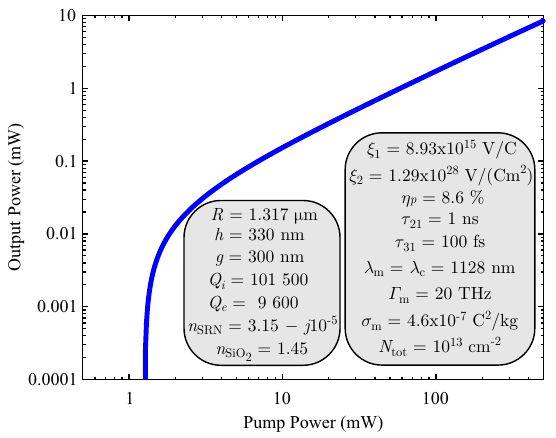
Figure 2. CW lasing output power of the proposed whispering- gallery cavity versus pump power. A low pump threshold of 1.3 mW is achieved and a clear, linear output is observed. The output power saturates for P p ∼ 10 W (not shown). Insets: Com- plete list of the parameters used for the